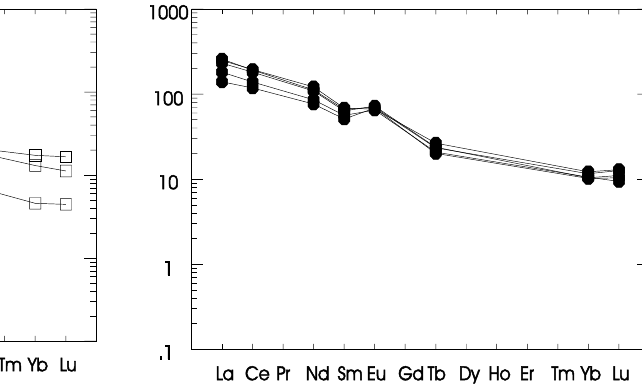
Fig. 7 – REE-spectra of samples of the megaporphyritic granite. Normalization after Boynton (1984). Explanation in text.